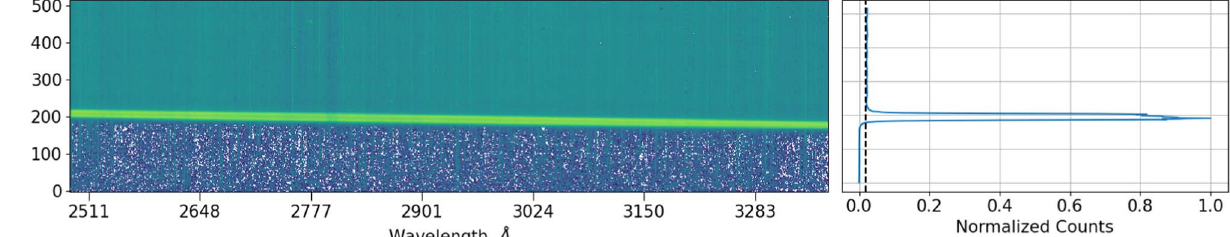
Figure 4. Left: 2048 × 515 CCD image of Castor ’ s spectra with the background subtracted. The spectrum is the bright green line in the image ’ s center. Below the spectrum is residual background subtraction noise, and above the spectrum is residual spectral light as the CCD is read out while the shutter remains open. CCD register clocking moves charges to the right and vertical clocking moves the charges down. Right: one-dimensional cross-section of the frame to illustrate the readout streak. The vertical dashed line marks the median value of the readout residual exposure at 2.2% of the normalized counts cross-section.